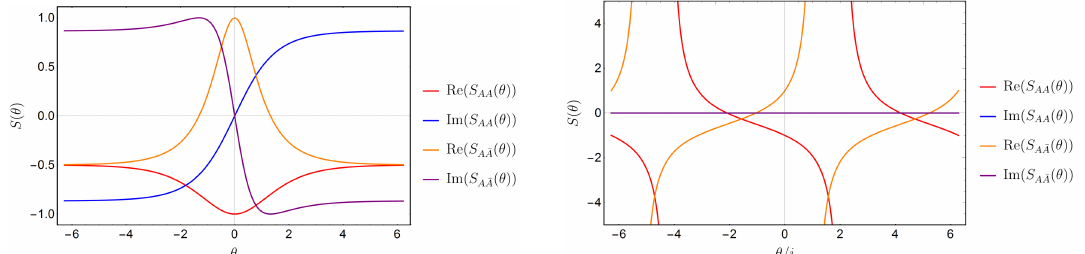
Figure 1 . Left: scattering amplitude for real rapidity difference (Im ( θ ) = 0 ) in the 3-state Potts model. When θ = 0 we have S ( θ = 0) = 1 and S AA ( θ = 0) = − 1 , while for | θ | → + ∞ the A ¯ A scattering amplitude goes to a constant. Right: scattering amplitude for imaginary values of the rapidity difference (Re ( θ ) = 0 ) in the 3-state Potts model. The imaginary part is vanishing and the amplitudes develop dynamical poles associated with the presence of a bound